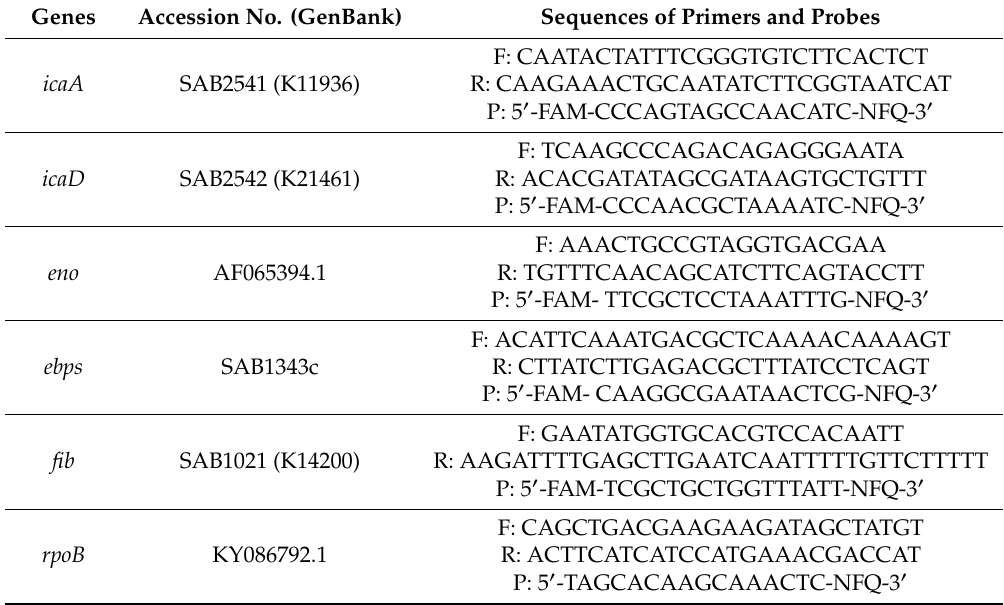
Table 2. Sequences of primers designed for quantitative real-time polymerase chain reaction (qRT-PCR)